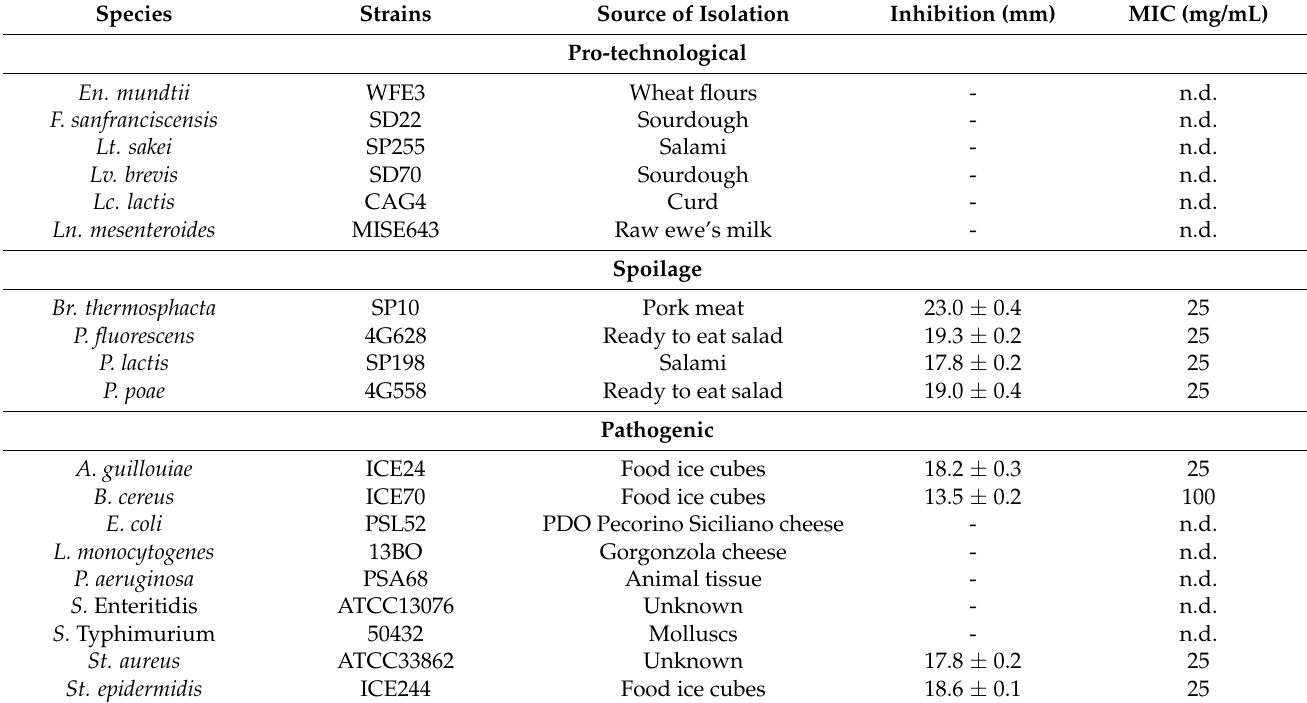
Table 3. Antibacterial activity of the ethanolic extract of